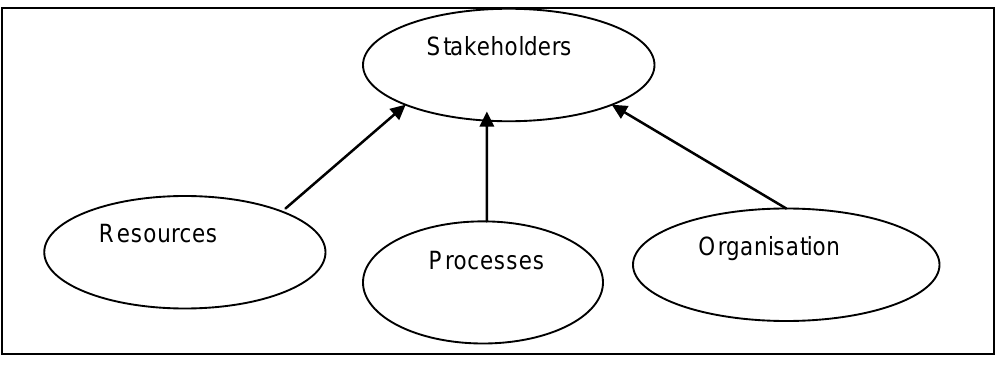
FIGURE 1: KOTLER’S HIGH -PERFORMANCE